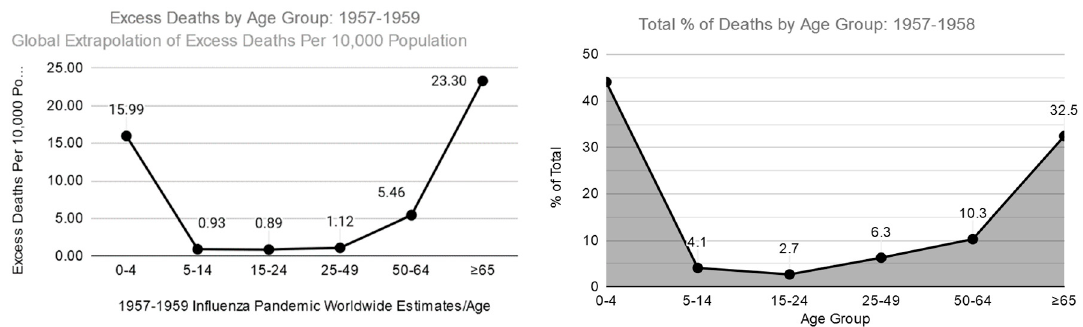
Figure 3. Excess deaths (right column) and total percentage of deaths (right column) due to 1957–1959 Influenza pandemic [40].